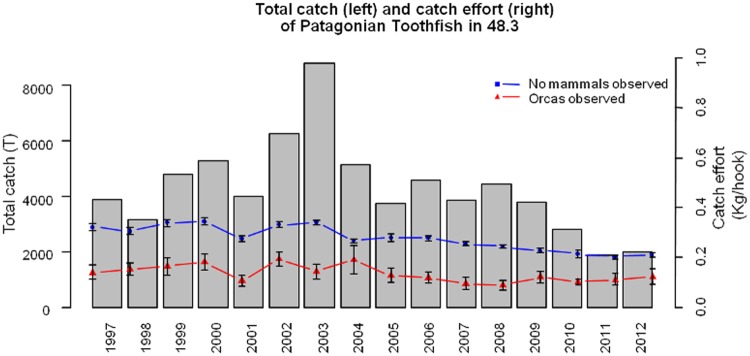
Historic catch rates comparison and total catch of Patagonian toothfish.Gray bars show total catch of toothfish, blue line shows catch rates without mammals at the longline set, and red line shows catch rates when orcas were observed at the longline set.